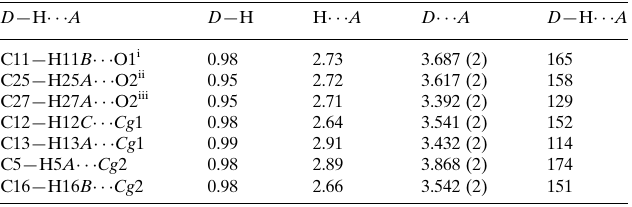
Hydrogen-bond geometry (A˚ , (cid:4) ). Cg 1 and Cg 2 are the centroids of the C29–C34 and C35–C40 rings, respectively. D —H (cid:2)(cid:2)(cid:2)